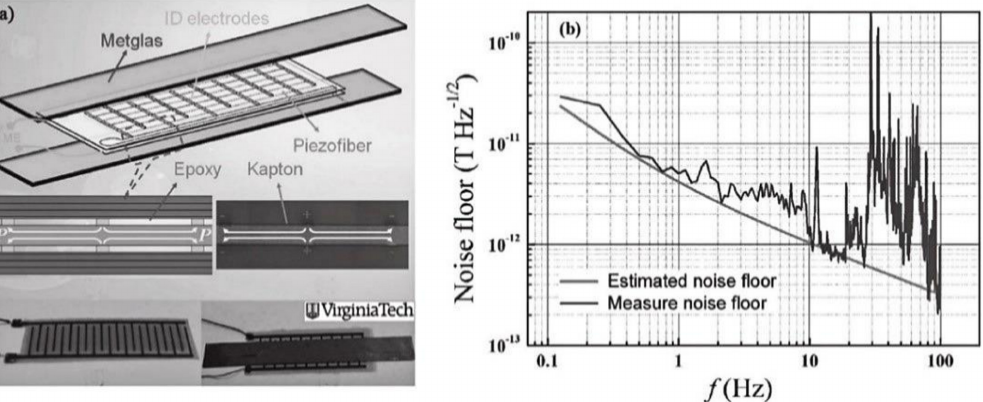
Figure 3. ( a ) Schematic diagram and the protype photo of 2-1 type ME composite working on multi-push-pull mode. ( b ) Measured and estimated equivalent magnetic noise of the proposed sensor unit